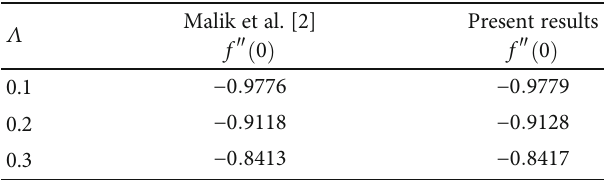
(vi) With an increase of reaction rate parameter ð σ Þ , the magnitude of the skin friction coe ffi cient remains constant but the magnitude of Nusselt number diminution and Sherwood number rises (vii) Sherwood number declines when the value of slip parameter ð γ Þ rises.